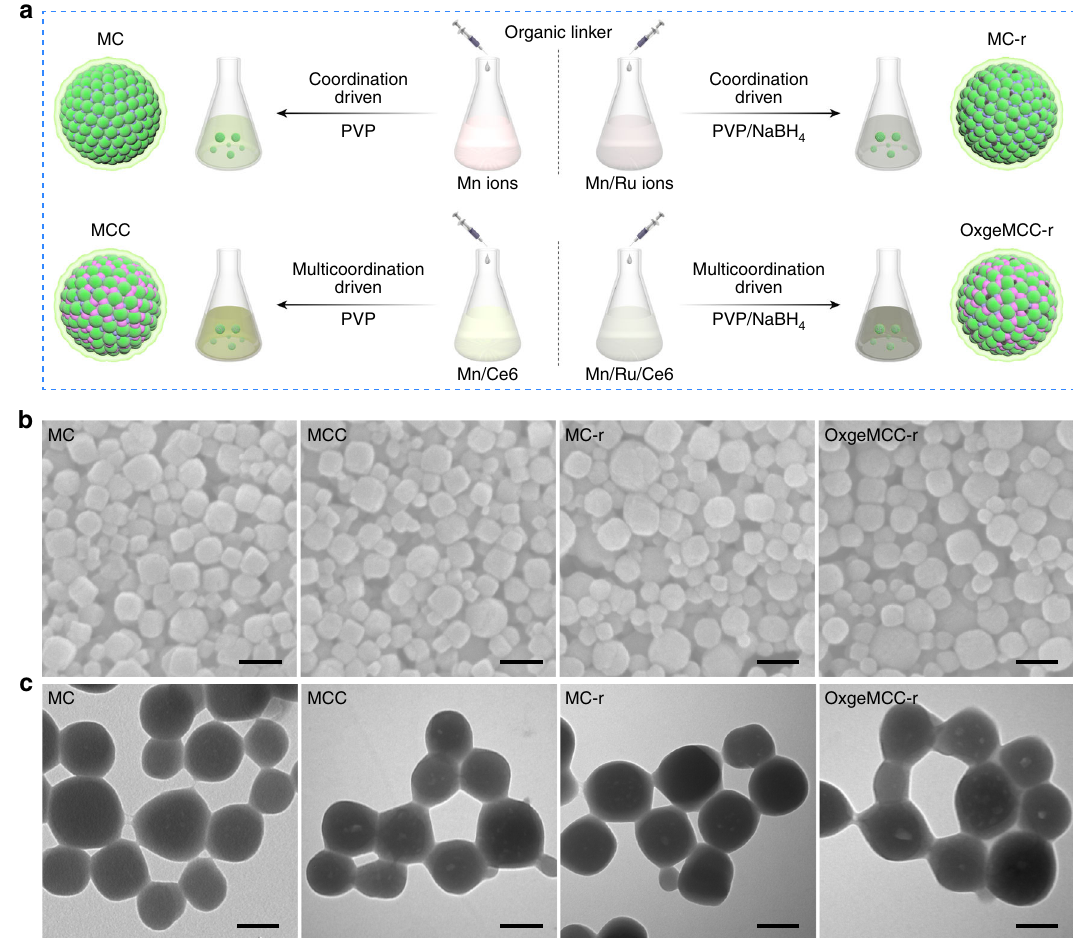
Fig. 2 Synthesis and morphology characterizations. a Schematic illustration for the self-assembly of MC, MCC, MC-r nanoparticles, and OxgeMCC-r SAE. The organic linker [Co(C ≡ N) 6 ] in syringe was added dropwise into four conical fl asks fi lled with different systems under vigorous stirring. Turbidity was observed immediately upon the addition of [Co(C ≡ N) 6 ] in the presence of PVP surfactant. b SEM images of the as-prepared MC, MCC, MC-r, and OxgeMCC-r. Scale bar is 100 nm. c Corresponding TEM images. Scale bar is 50